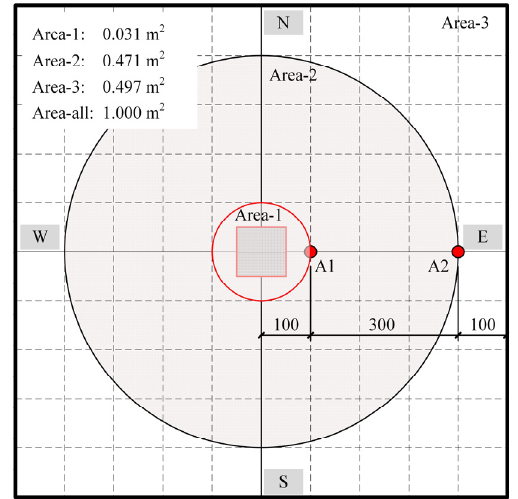
Figure 7. Integration areas of the inertial force.